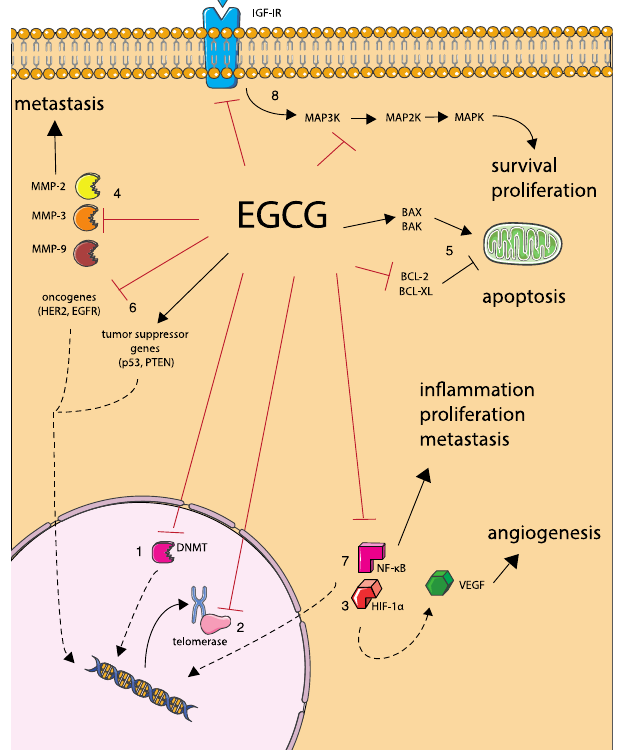
Figure 2. Cancer-related cell mechanisms modulated by EGCG: ( 1 ) Inhibition of DNA hypermethylation by direct blocking of DNA methyltransferase (DNMT); ( 2 ) Repression of telomerase activity; ( 3 ) Inhibition of angiogenesis by repression of transcription factors Hypoxia-inducible factor 1- α (HIF-1 α ) and Nuclear factor kappa B (NF- κ B); ( 4 ) Blocking of cell metastasis by inhibition of Matrix metalloproteinases (MMPs) -2, -9 and -3; ( 5 ) Promotion of cancer cell apoptosis by induction of pro-apoptotic proteins BCL-2-associated X protein (BAX) and BCL-2 homologous antagonist killer (BAK) and repression of anti-apoptotic proteins B-cell lymphoma 2 (BCL-2) and B cell lymphoma-extra large (BCL-XL); ( 6 ) Induction of tumor suppressor genes p53 and Phosphatase and tensin homolog ( PTEN) and inhibition of oncogenes Human epidermal growth factor receptor 2 ( HER2 ) and Epidermal growth factor receptor ( EGFR ); ( 7 ) Inhibition of NF- κ B and subsequent events of cell inflammation, proliferation, metastasis and angiogenesis; and ( 8 ) Anti-proliferative activity by inhibition of Mitogen-activated protein kinases (MAPK) pathway and Insulin-like growth factor I receptor